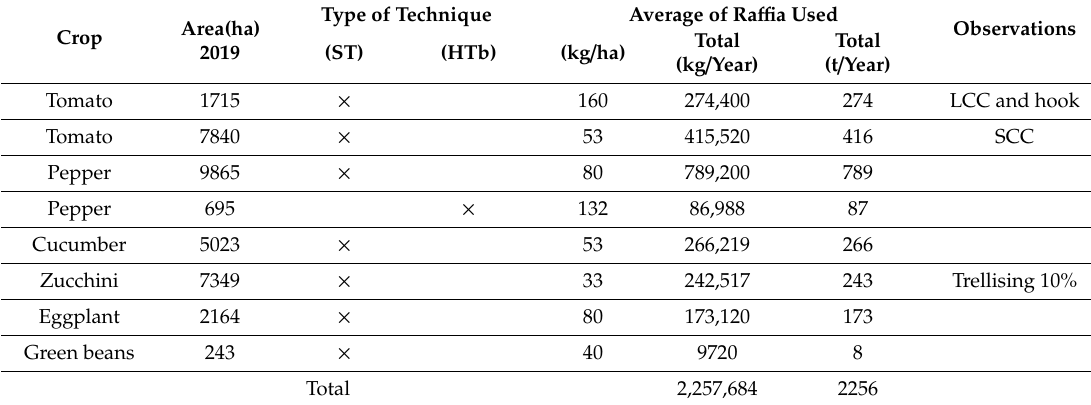
Table 2. Main trellised crops in the province of Almer í a and estimation of the amount of ra ffi a used by type of